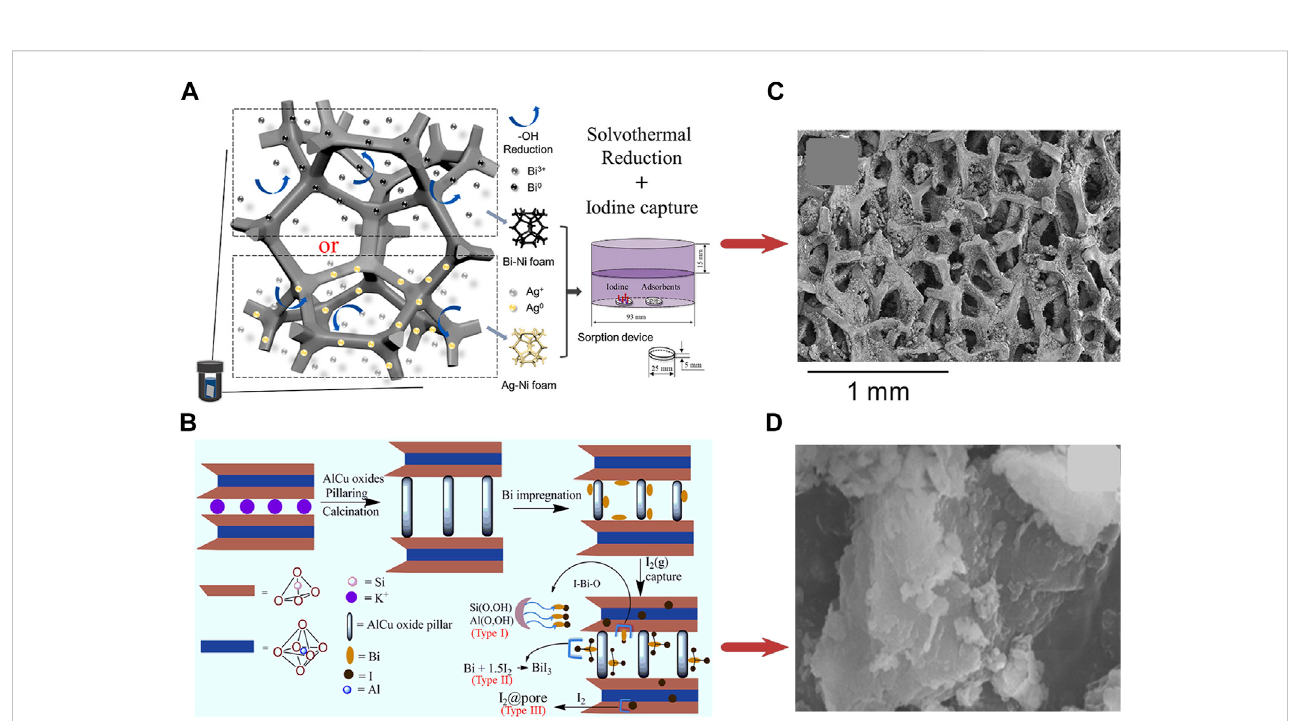
FIGURE 7 (A) PreparationandIodineAdsorptionofBi-NiandAg-Nifoams; (B) SEMimageofI-Bi-Nifoam(Tianetal.,2021b); (C)